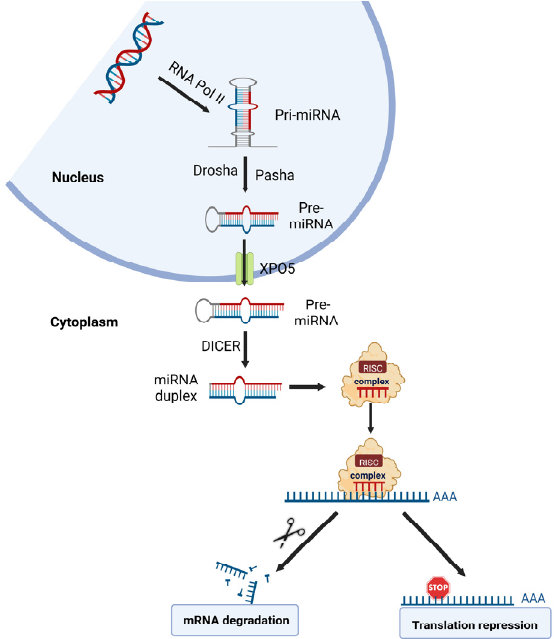
Figure 3. The schematic diagram of microRNA biogenesis and roles in gene expression.